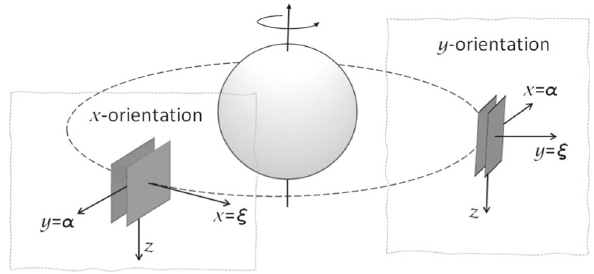
Fig. 2 Orientations of the Casimir apparatus for the Kerr metric